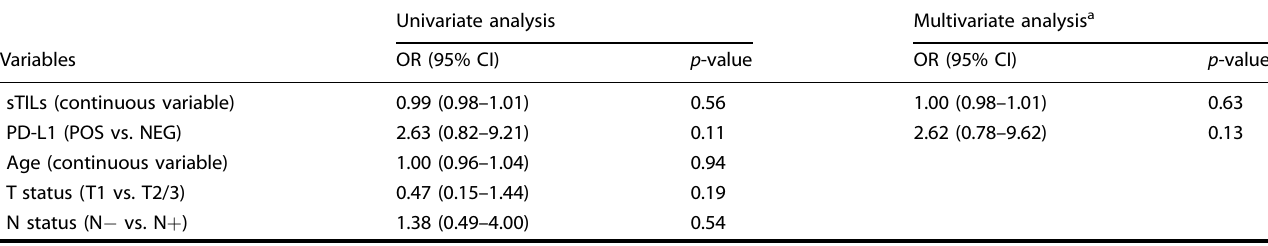
Table 2. Univariate and multivariate logistic regression analyses to identify possible independent predictors of pCR following neoadjuvant therapy.